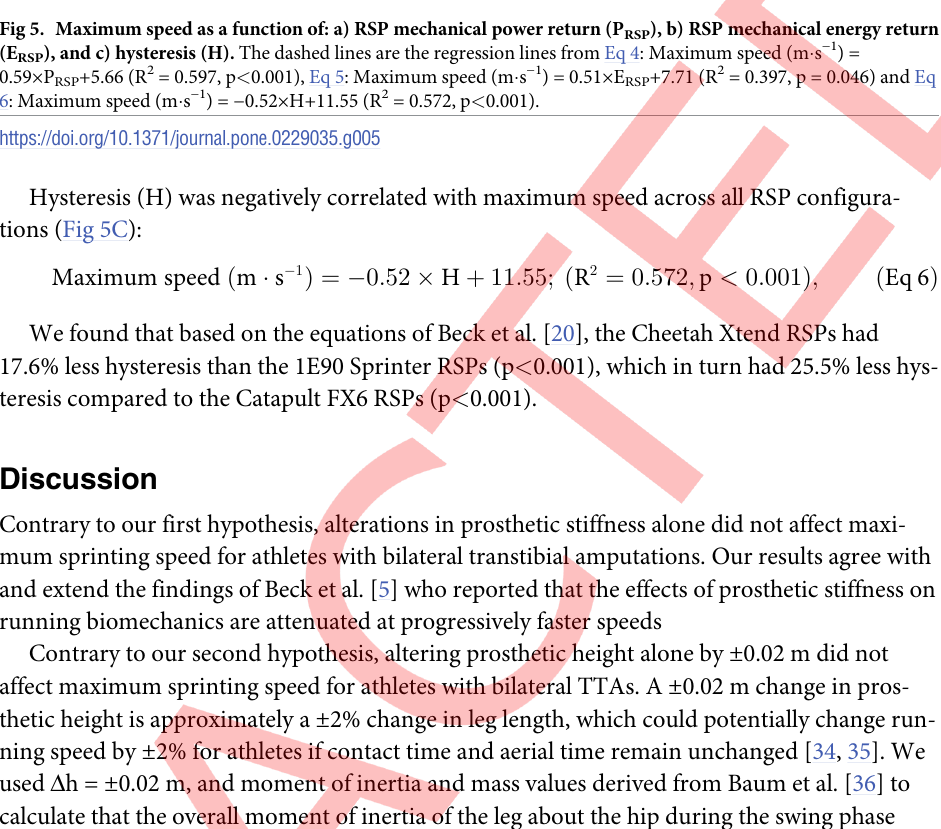
Fig 5. Maximum speed as a function of: a) RSP mechanical power return (P RSP ), b) RSP mechanical energy return (E RSP ), and c) hysteresis (H). The dashed lines are the regression lines from Eq 4: Maximum speed (m � s − 1 ) = 0.59 ×